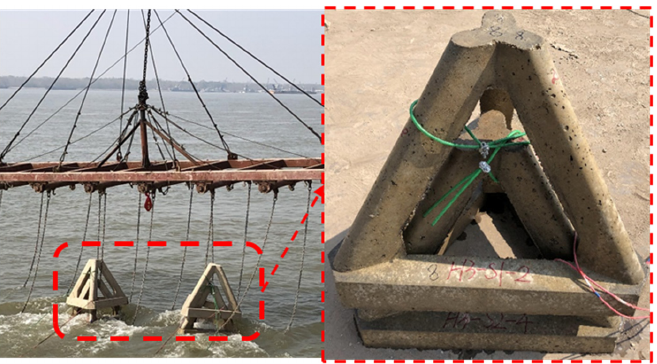
Figure 11. Submerged in and salvaged from the river to inspect the